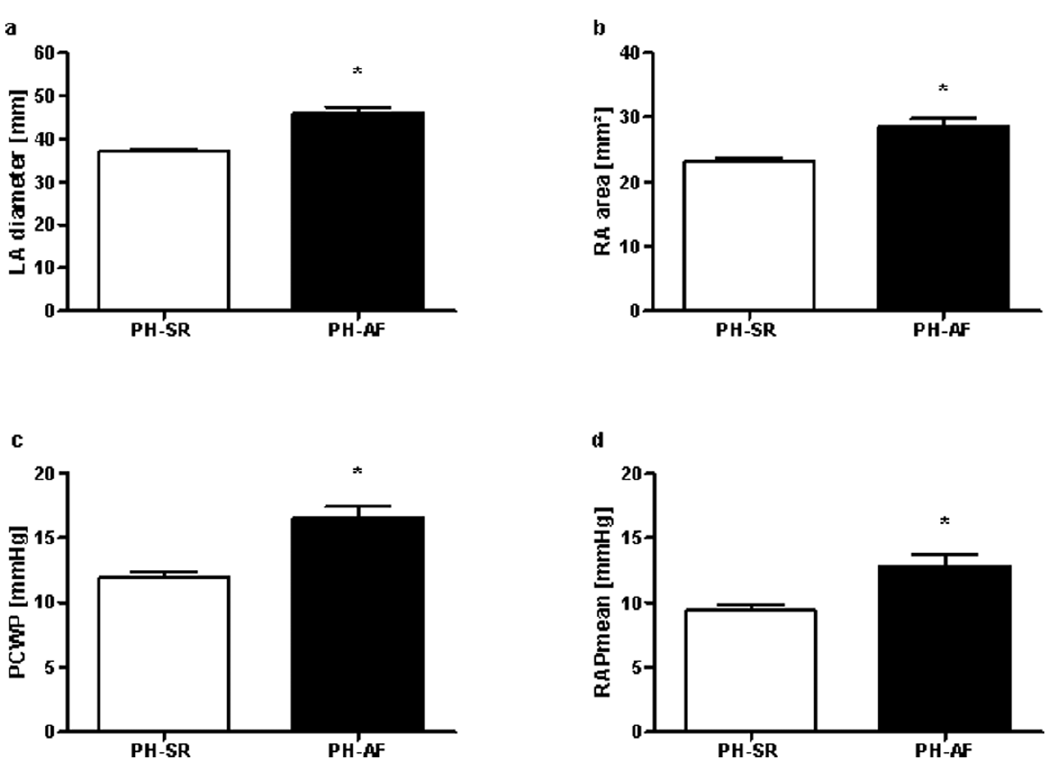
Figure 2. Hemodynamic parameters associated with AF in PH. Left atrial (LA) diameter and right atrial (RA) area were measured by echocardiography in PH-AF compared to PH-SR. PCWP and mean right atrial pressure (RAPmean) were obtained by right heart catheterization in the presence (PH-AF) or absence (PH-SR) of AF in patients with PH. * p , 0.05.